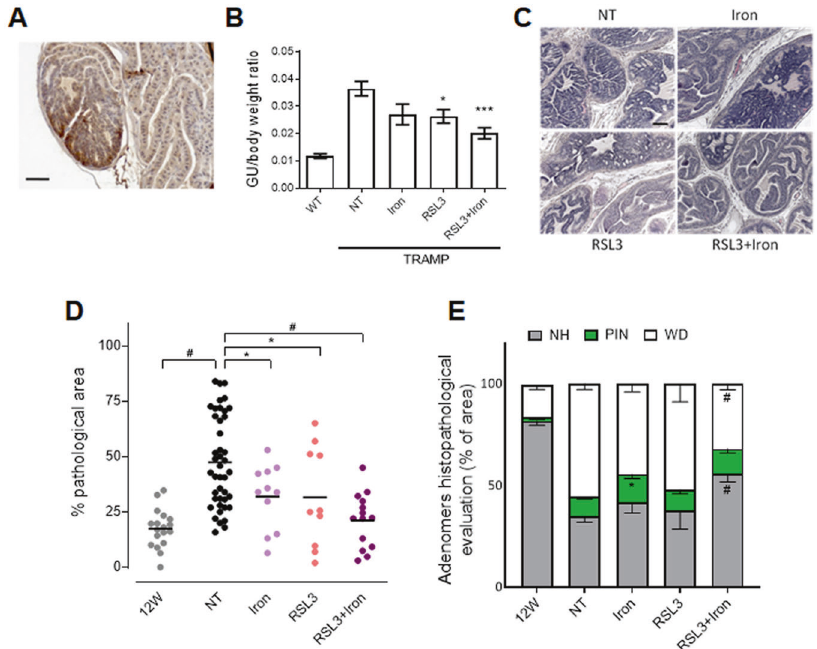
Fig. 5 RSL3 + iron impairs tumor growth in the multistage TRAMP PCa model. A Immunohistochemistry for transferrin receptor (TfR1) in the anterior prostate lobes of 25 week-old TRAMP mice (scale bar = 100 μ m). B TRAMP mice were treated with iron dextran 40 mg/kg/week, RSL3 10 mg/kg/week and RSL3 + iron from 12 weeks of age until 25 weeks of age. Wild type mice, as well as no treated (NT) and treated TRAMP mice were sacri fi ced at 25 weeks of age and the genitourinary to body weight ratio determined. C Representative picture (H&E) of anterior prostate lobes of TRAMP mice at 25 weeks of age. (scale bar = 100 μ m). D Quanti fi cation (percentage) of the pathologic area in the anterior prostate of 12 and 25-week-old untreated TRAMP (12 W and NT respectively) and treated TRAMP mice of 25 week-old. E Histopathologic evaluation of prostate tissue after explantation; the graph shows the percentage of normal healthy tissue (NH, gray), PIN (green), and well- differentiated tumor area (WD, white) in the prostate of untreated TRAMP (12 and 25-week-old) and treated TRAMP mice of 25 week-old. Data are the mean ± SEM of 8 – 10 mice/group. * p < 0.05 , ***p < 0.001, # p < 0.0001 refers to each group vs NT